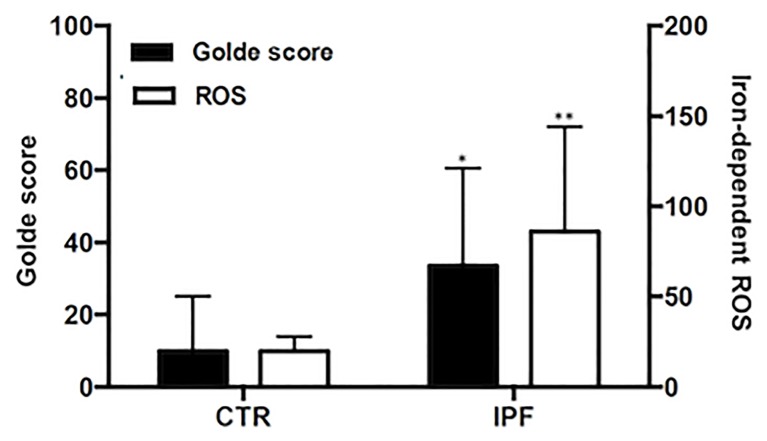
Intracellular iron and ROS levels in BAL cells.Alveolar macrophage intracellular iron was assessed using the Prussian Blue Iron Staining and the Golde score was calculated based on the staining intensity 14 IPF patients and 7 controls. Reactive oxygen species (ROS) were measured in 11 IPF patients and 7 controls, using CM-H2DCFDA fluorimetry. Shown are Golde scores and chelatable iron-dependent ROS levels per 105 BAL cells in healthy controls and IPF affected individuals.